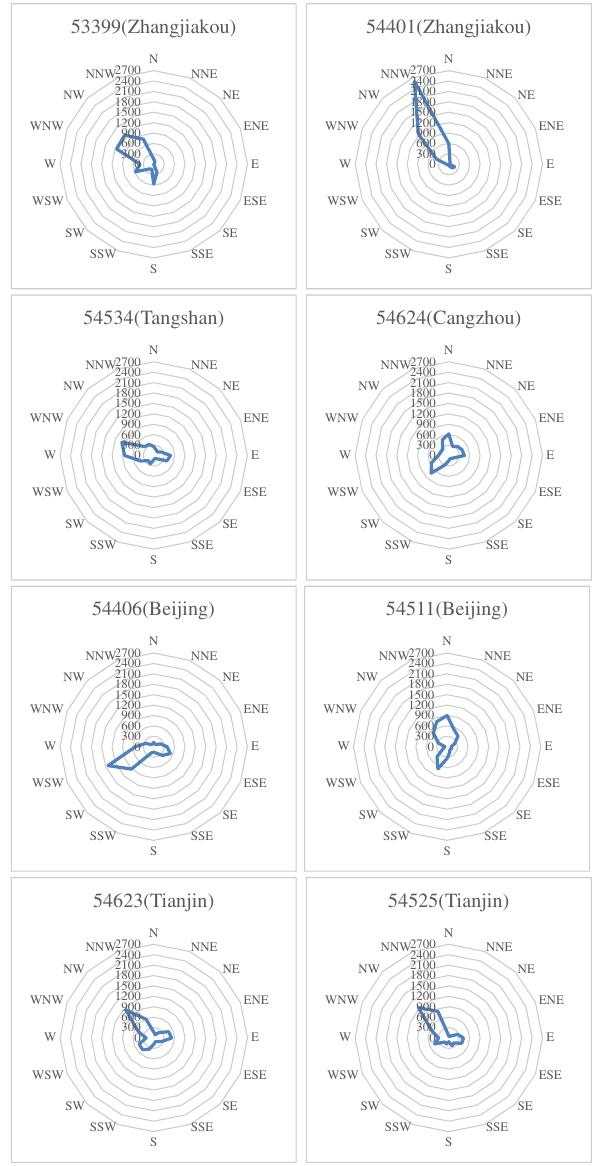
Figure 3. Maximum wind direction rose diagrams for some stations in the Beijing–Tianjin–Hebei